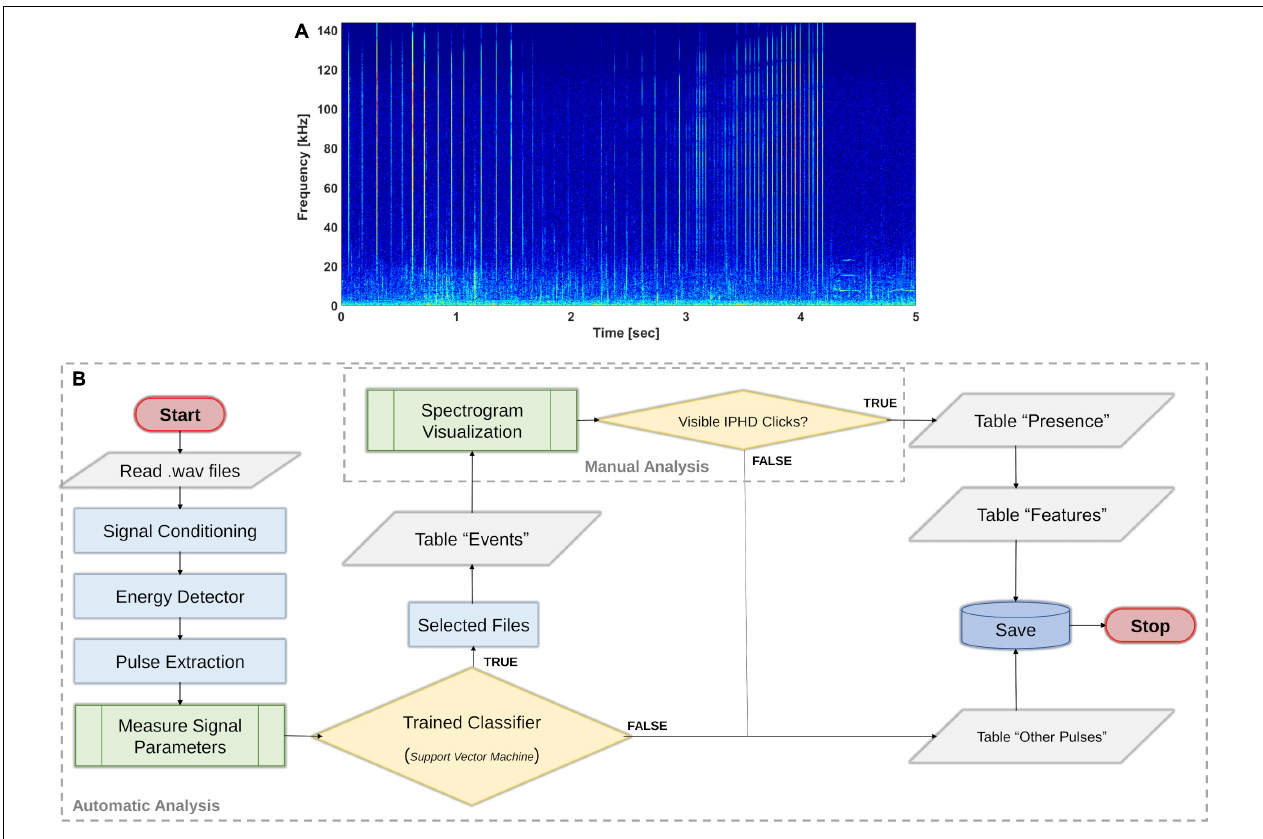
FIGURE 5 | Identification of IPHD clicks. (A) Spectrogram (nfft = 2048; overlap = 50; Hann window) of 5-s file interval with IPHD clicks. (B) The flowchart (International standard symbols for flowchart, ISO 5807:1985) shows the procedure applied for click classification and data analysis. The method considered the application of the trained classifier ( Automatic Analysis ) and an intermediate step to check the results through spectrogram analysis ( Manual Analysis ). Additional information about IPHD acoustic behavior and other sound sources were also logged during spectrogram visualization and